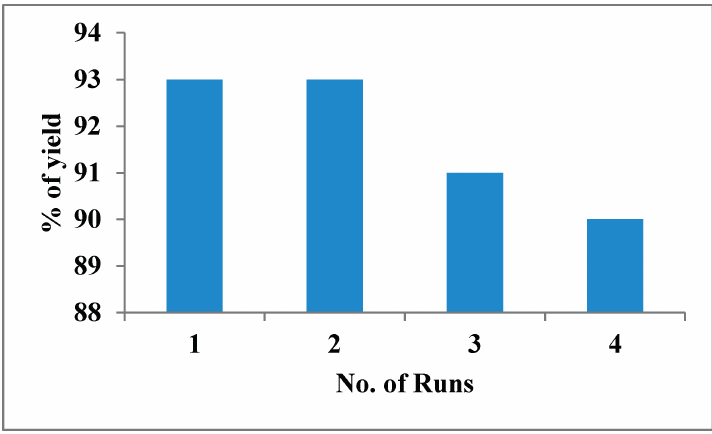
Figure 6. Reusability of